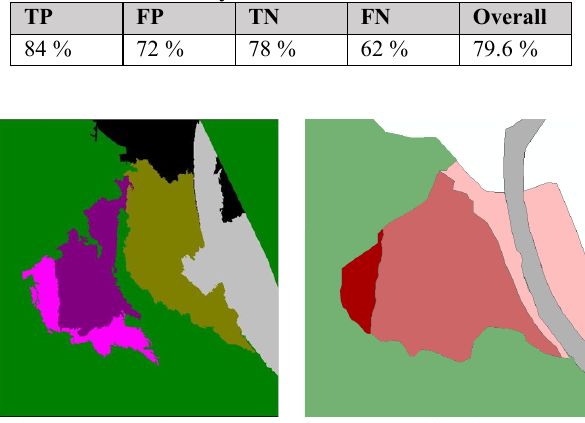
Figure 8. OBIA knowledge-based classification result (left) and manual digitization result